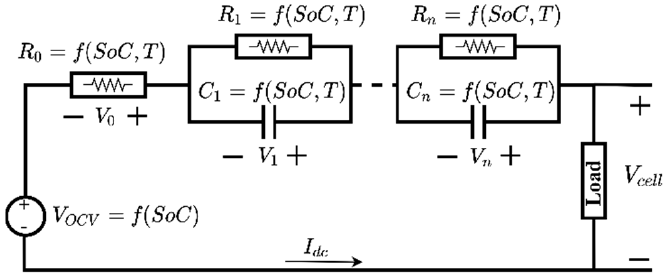
Figure 4. RC Battery equivalent model.